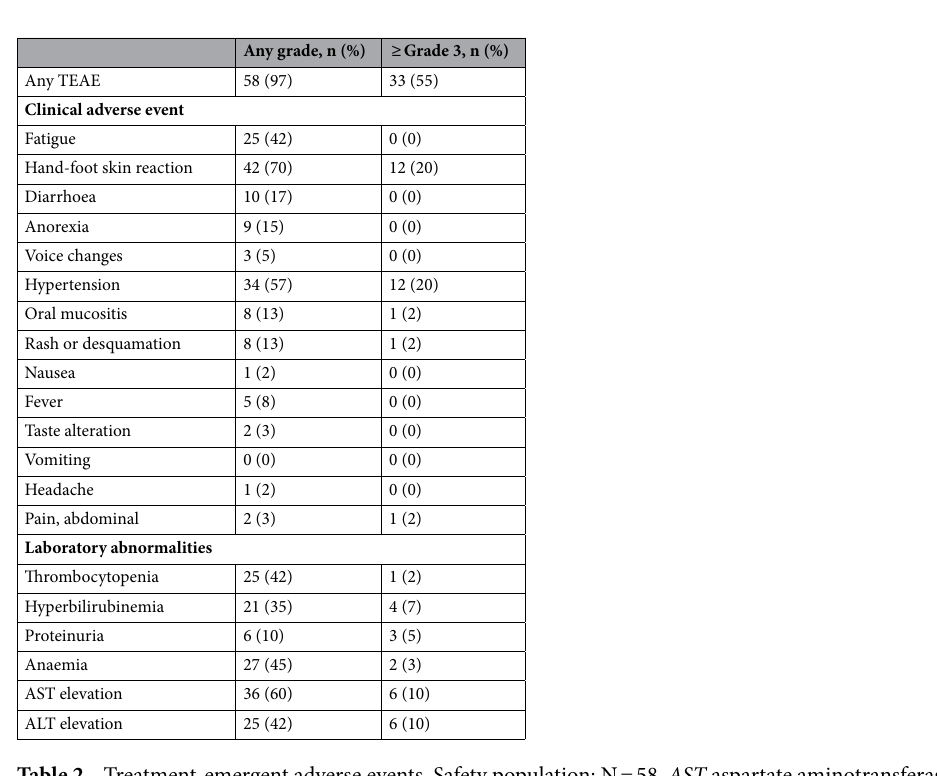
Table 2. Treatment-emergent adverse events. Safety population; N = 58. AST aspartate aminotransferase, ALT alanine aminotransferase, TEAE treatment-emergent adverse event.